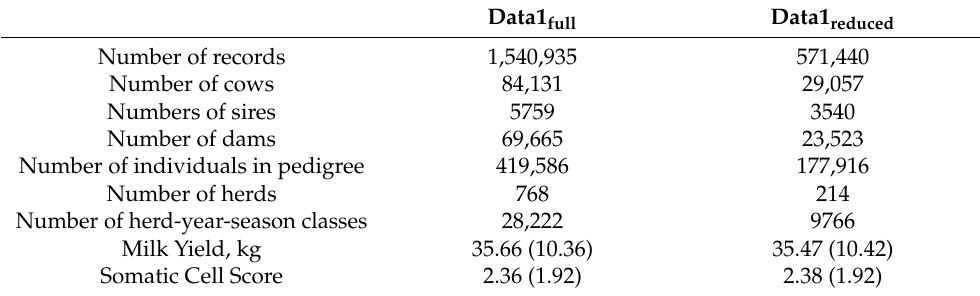
Table 1. Descriptive statistics for the datasets including test-day records and used in the